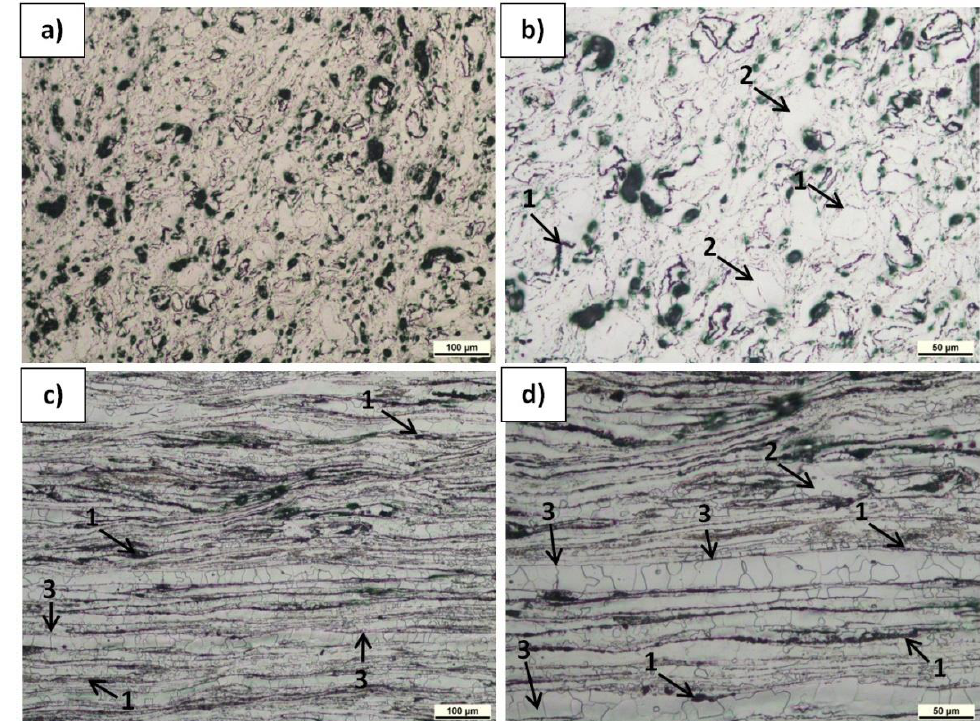
Figure 7. LM micrographs of etched transverse ( a,b ) and longitudinal ( c,d ) sections of Mg(S) rod KOBO-extruded: 1 — MgO bands, 2 —α -Mg grains, 3 —α -Mg grains of shape determined by MgO bands distribution.